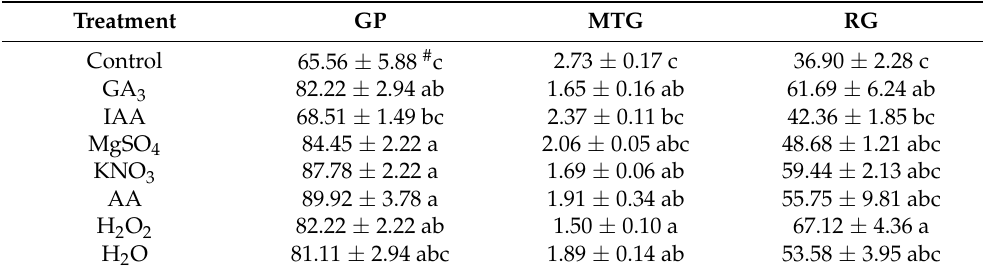
# The values represent the means of six replicates ± standard error. Different letters indicate signifi- cant differences ( p ≤ 0.05) between treatments according to Tukey’s test.